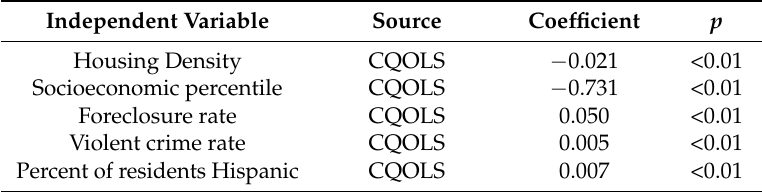
Figure 8. Sum of gravid A. albopictus caught over 12 weeks in each selected NPA (small circle: fewer total samples; large circle: more total samples). Table 3. Results of the first GLM predicting the abundance of gravid Ae. Albopictus